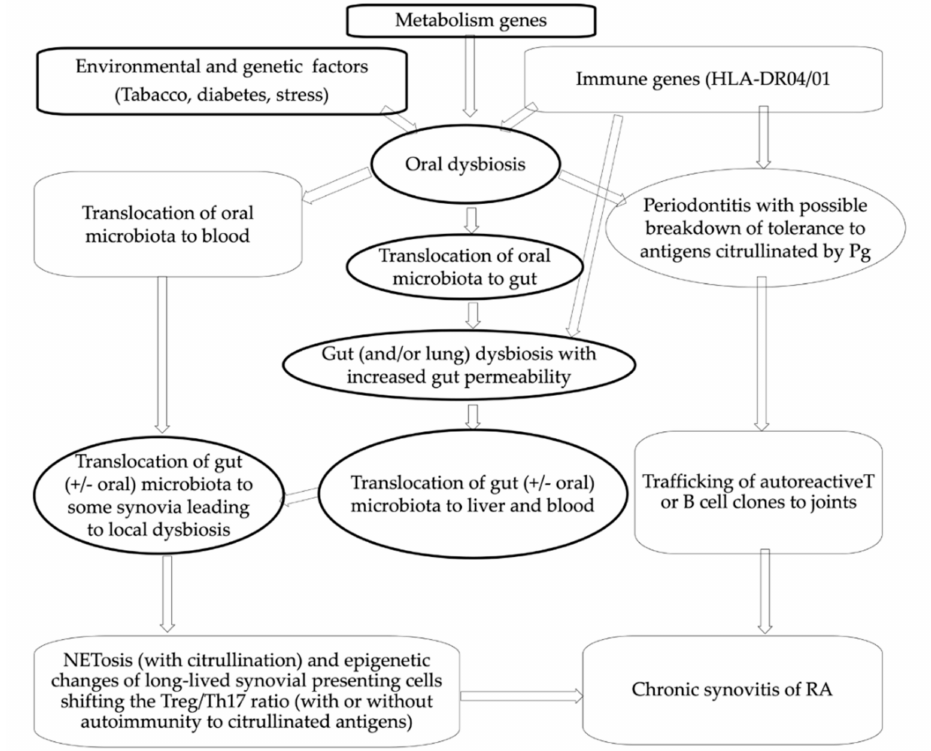
Figure 2. New look at oral bacterial contribution to